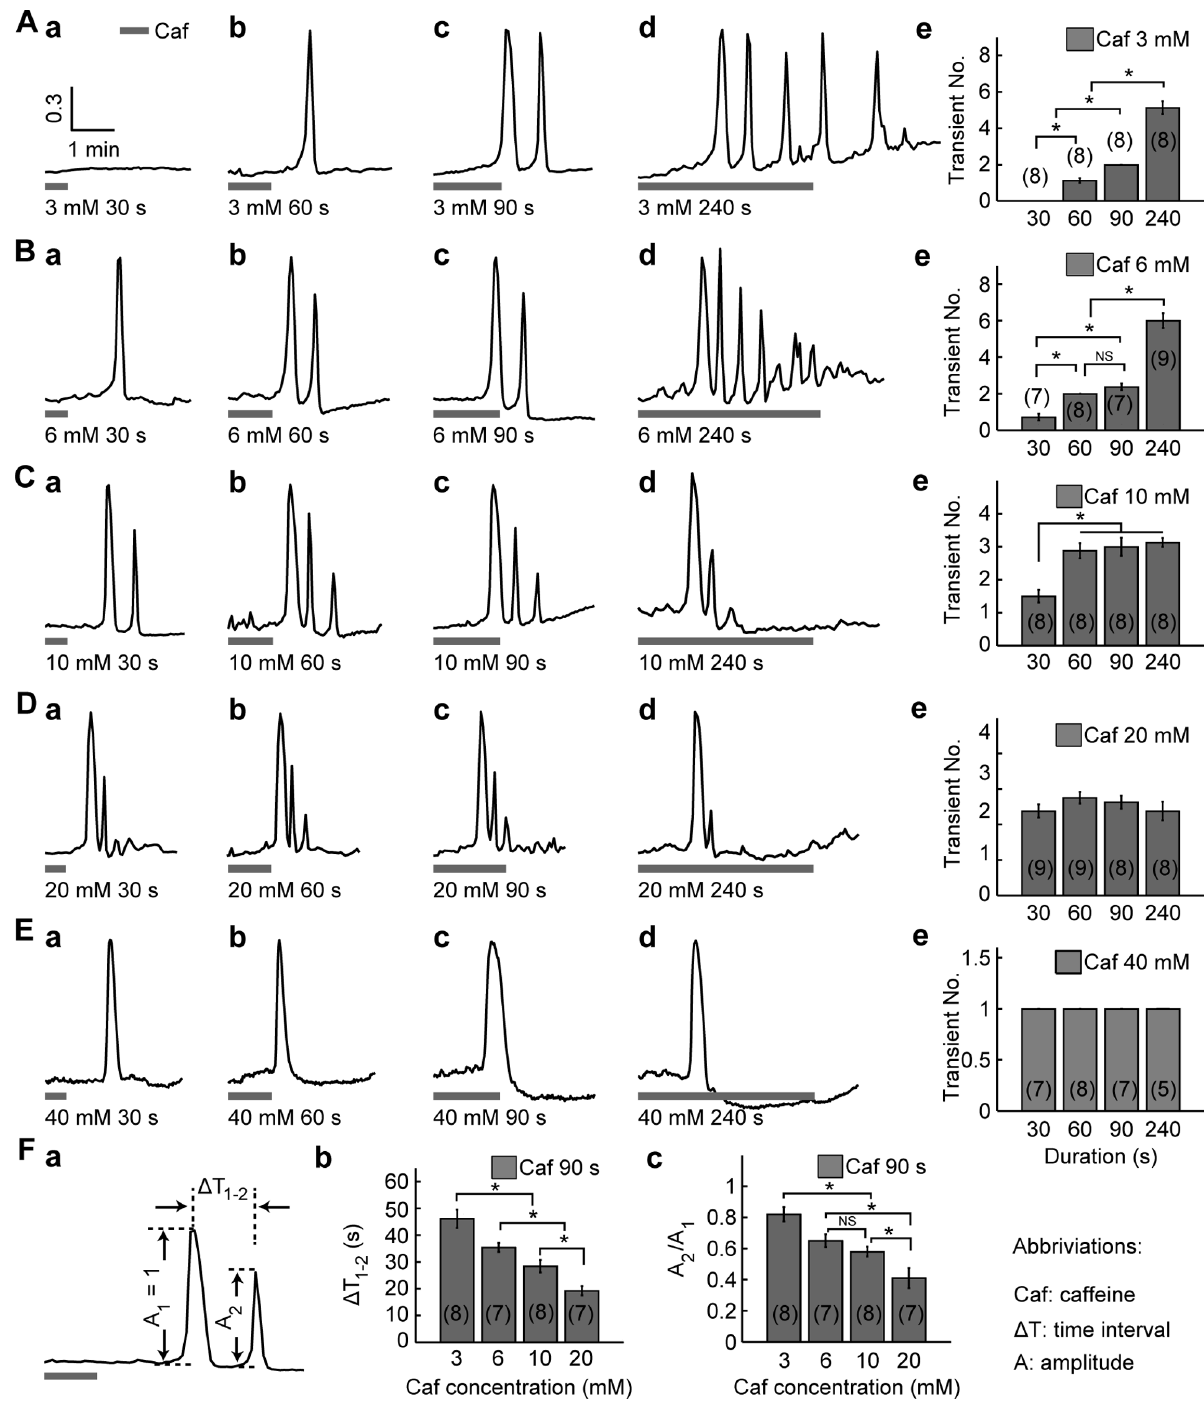
Figure 1. Caffeine induced [Ca 2 + ] i increase in a duration- and concentration-dependent manner. A–E, [Ca 2 + ] i transients induced by the application of 3, 6, 10, 20, and 40 mM caffeine, respectively. Columns (a)-(d), [Ca 2 + ] i transients induced by the application of caffeine for 30, 60, 90, and 240 s, respectively. Column (e), The average number of [Ca 2 + ] i transients (transient NO.) induced by various durations of caffeine application under each concentration. F, Dependence of caffeine-induced [Ca 2 + ] i responses (with identical application time of 90 s) on caffeine concentration. (a), Definition of amplitude and time interval between the first and the second Ca 2 + peaks ( D T 1–2 ). The amplitude of the second [Ca 2 + ] i transient (A 2 ) is normalized against that of the first one (A 1 ). (b), D T 1–2 decreased with caffeine concentration. (c), A 2 /A 1 decreased with caffeine concentration. Horizontal bars bellow the traces indicate the periods of caffeine applications. With our perfusion rate being 1 ml/min, 1 min was needed for the drug to reach the perfusion chamber. In this and subsequent figures, each trace is the representative of a group of independent experiments, and data are presented as mean 6 SEM (with sample size in parentheses). * denotes statistical significance of p , 0.05 by one-way ANOVA followed by post hoc SNK test, NS: not significant.